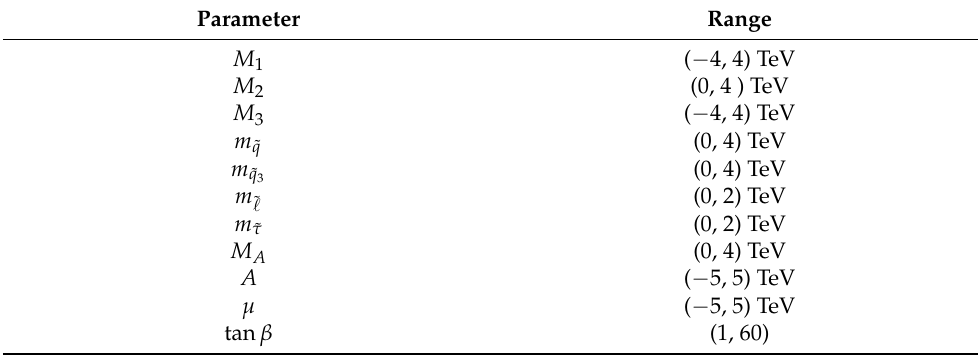
Table 1. The ranges of the sampled pMSSM11